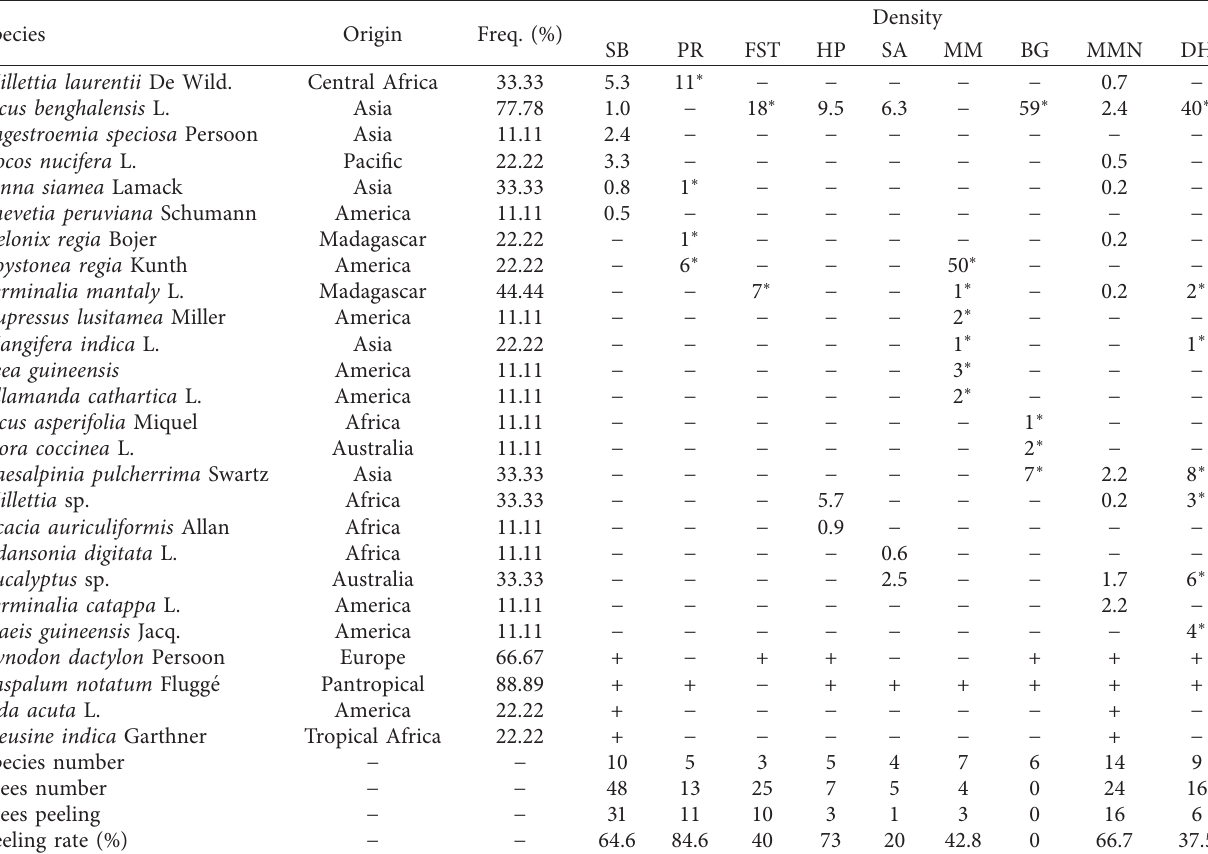
Table 2: Synopsis of the flora of Brazzaville green spaces.